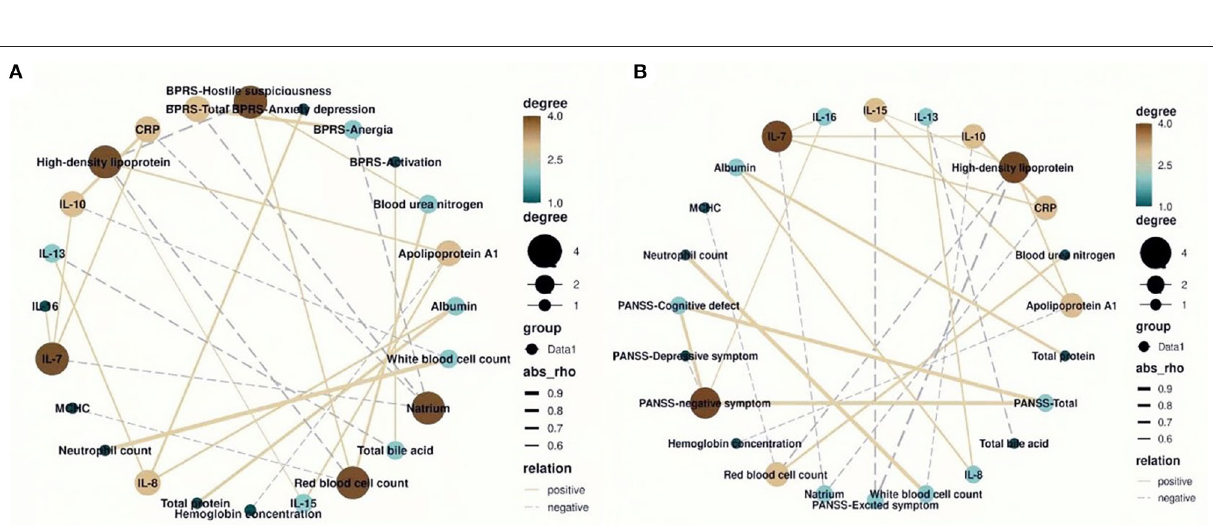
Frontiers in Psychiatry |